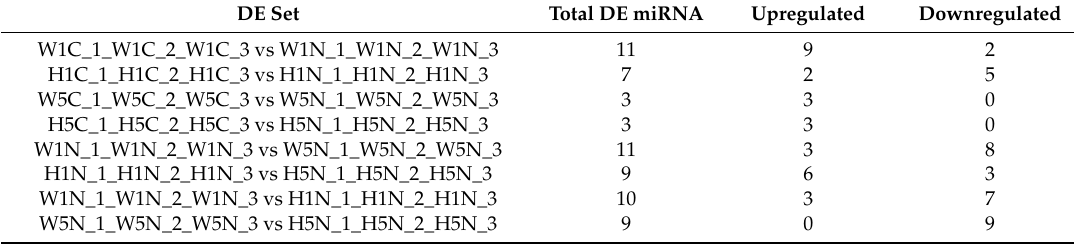
Table 3. The number of di ff erentially expressed miRNAs in each